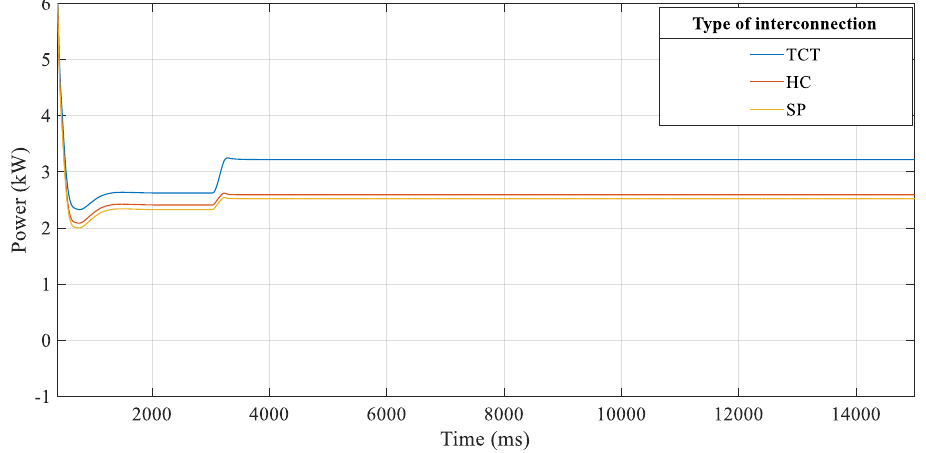
Figure 25. Impact of multiple faults ‘F4′ on power grid (monocrystalline PV).